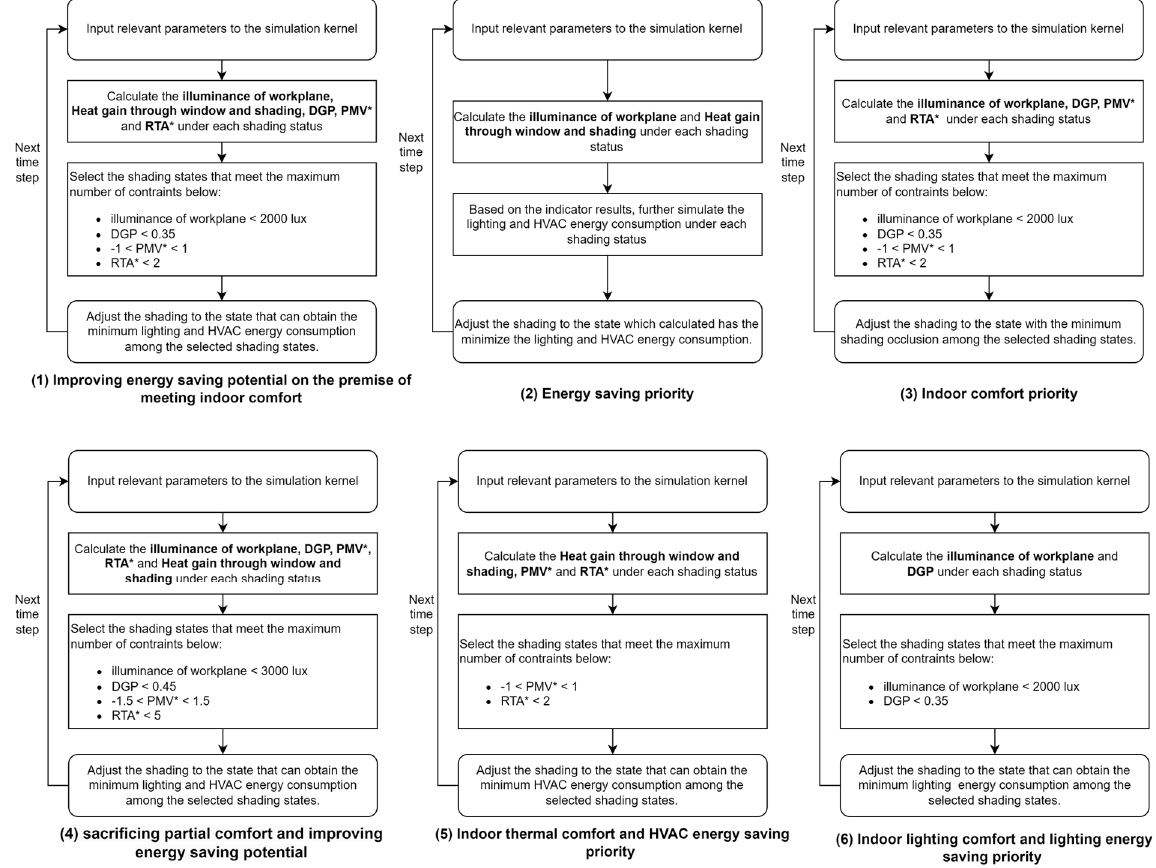
Figure 5. Six typical index − based control strategies.